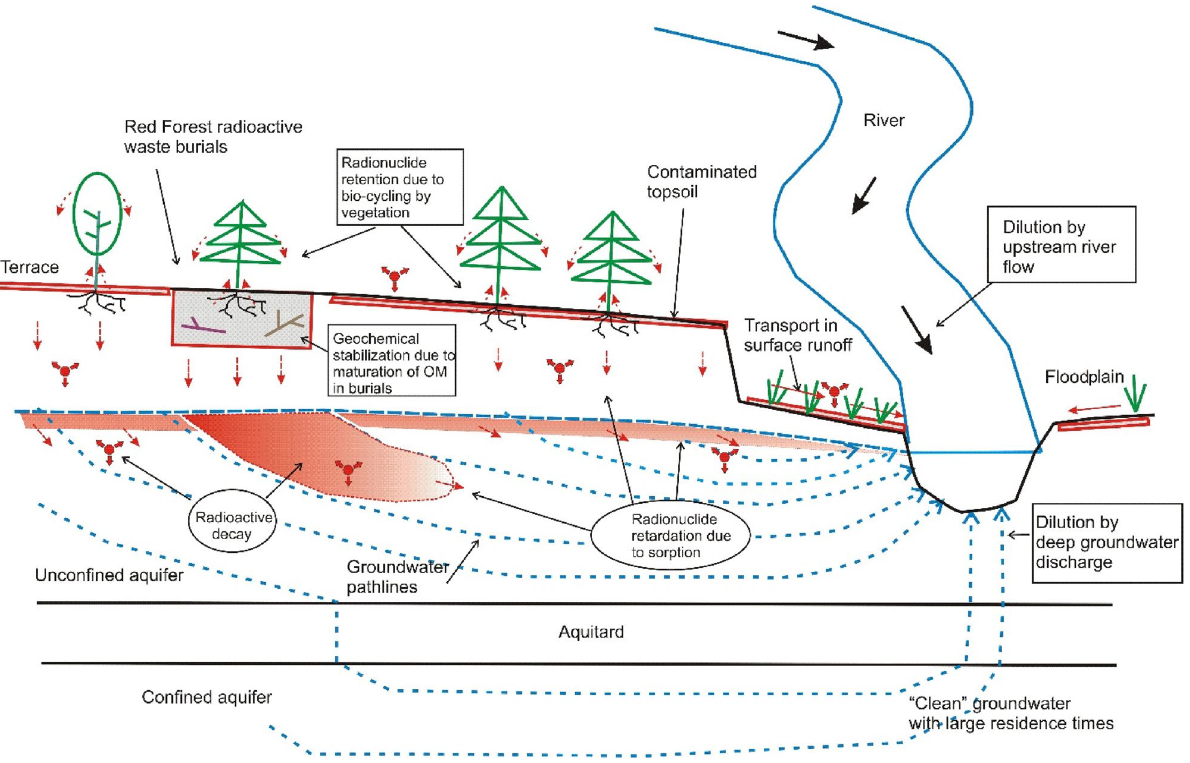
Figure 8. Conceptual scheme of natural attenuation processes in groundwater and surface water of the